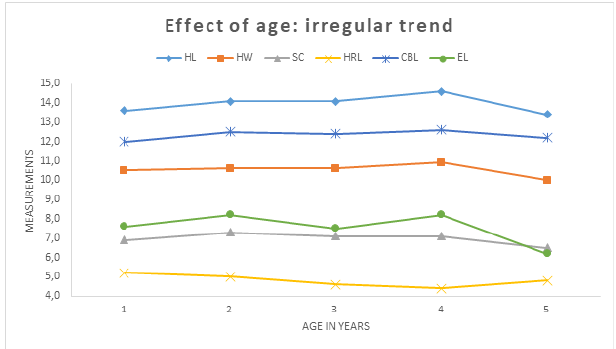
Figure 4. Effect of age on head length(HL), head width (HW), shin circumference (SC), hair length (HRL), canon bone length (CBL), and ear length (EL)